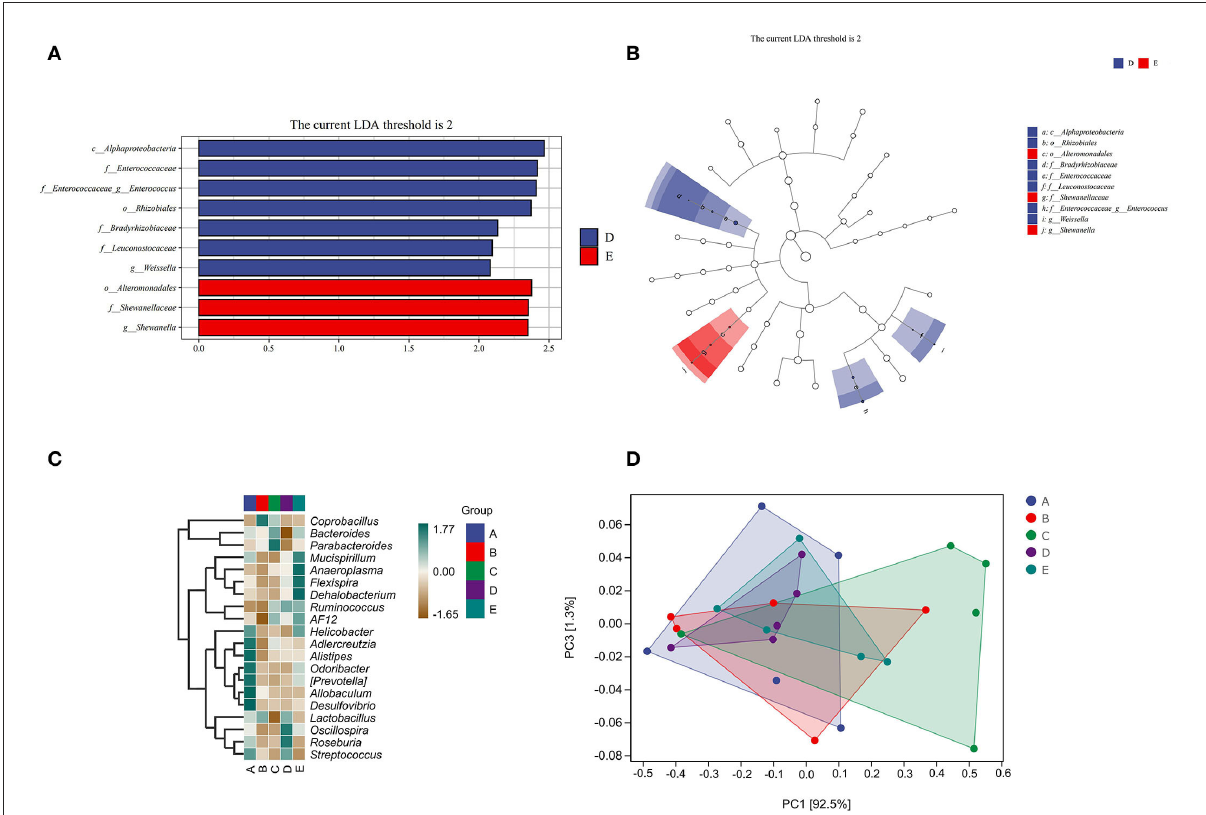
FIGURE6 The effect of CSPCM on species differences and marker analysis in mice samples. (A,B) LEfSe analysis of intestinal flora. (C) Heat map of intestinal flora. (D) PCOA analysis of intestinal